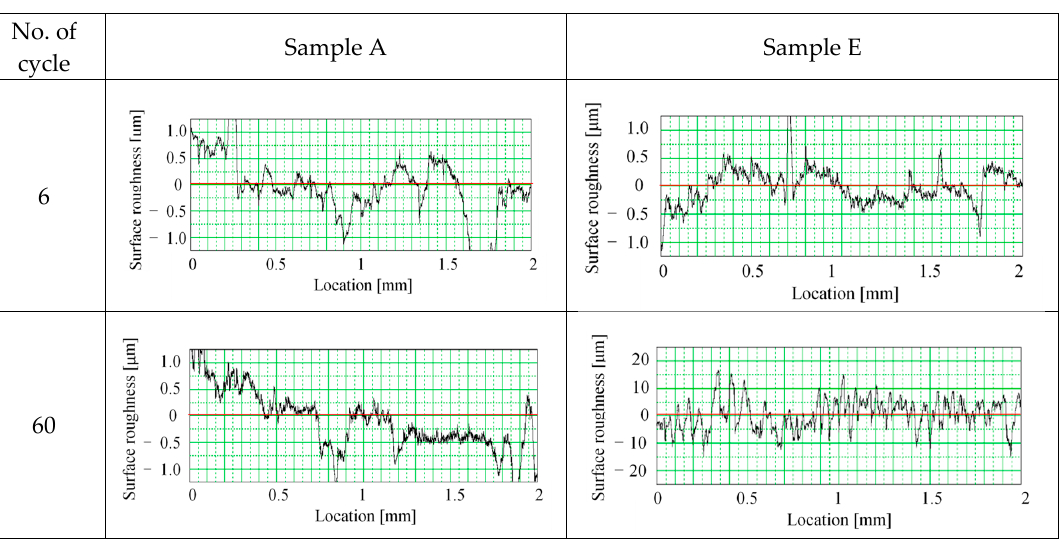
Figure 7. Examples of surface roughness profiles obtained with surface roughness meter in the 100-cycle test with 1 mm air gap.